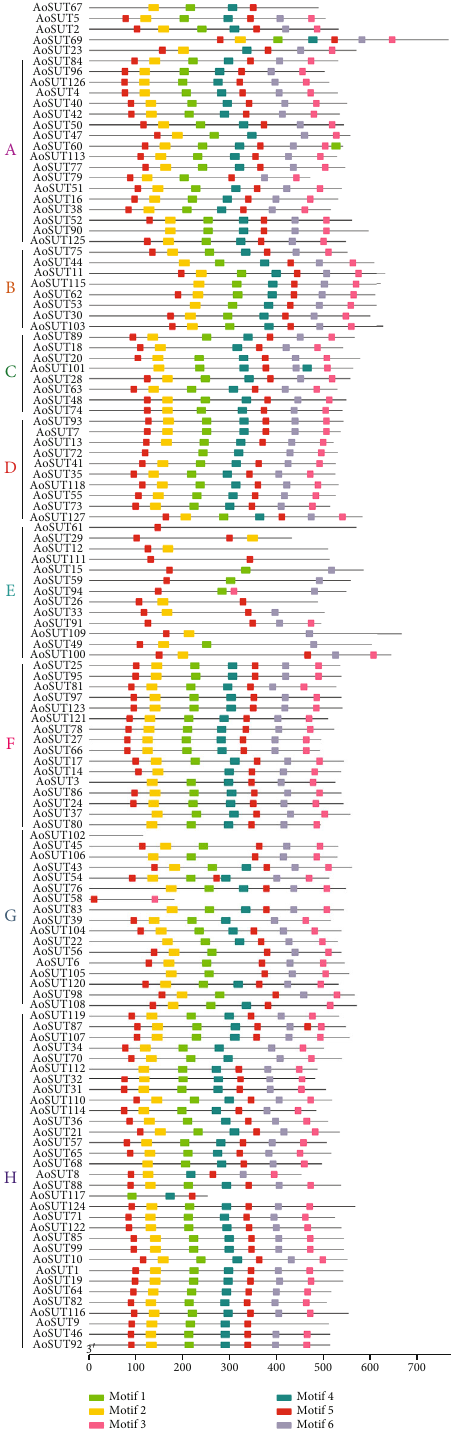
Figure 2: Conserved motifs of the SUT gene family in A. oryzae . All conserved motifs of the AoSUT proteins were identi fi ed by the MEME program. Protein sequences are indicated by thick gray lines, and the conserved motifs are represented by di ff erent colored boxes. The length (the number of amino acids) of the protein and motif can be estimated using the scale bar at the